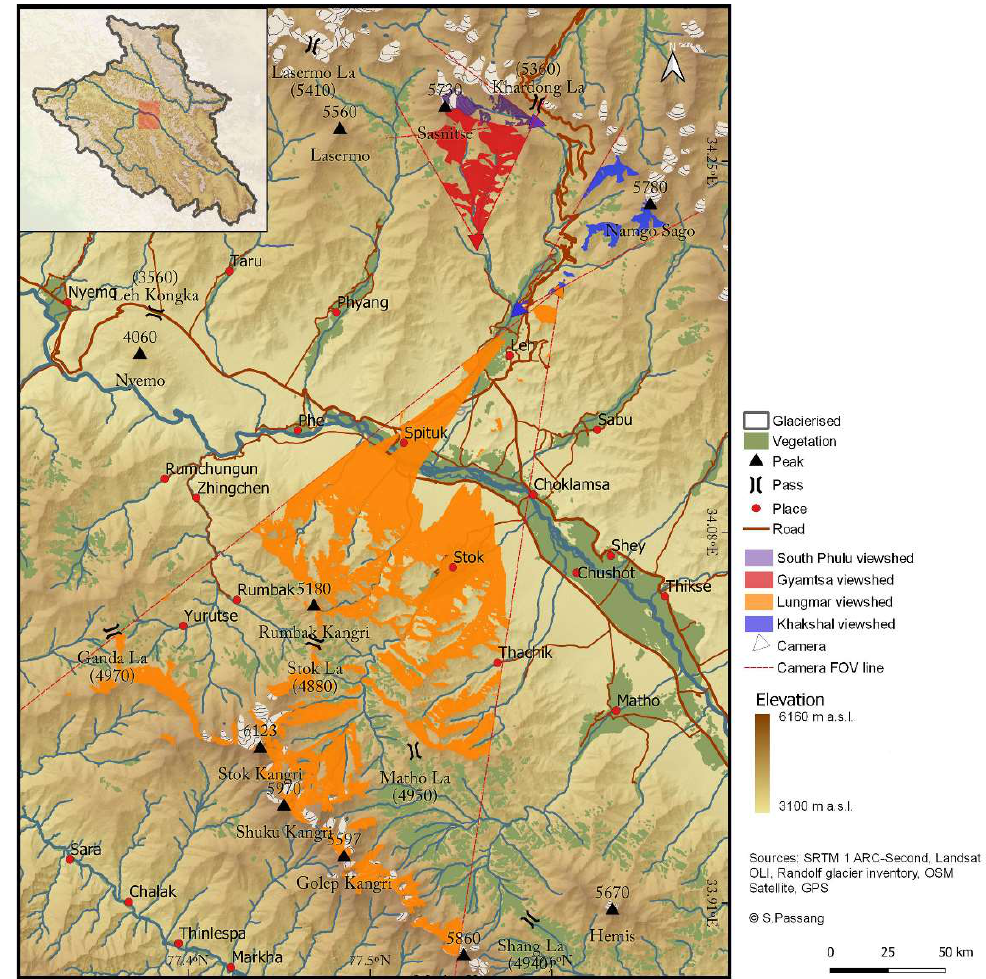
Figure 3. Locations and viewsheds of four terrestrial cameras. Gyamtsa (red) and Lungmar (orange) were used for MODIS validation in the present study.